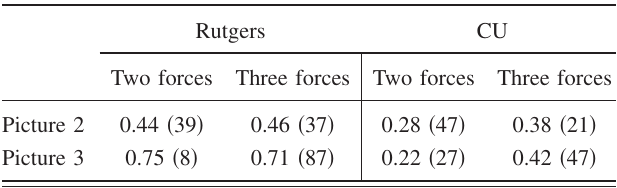
TABLE V. Fraction of students answering the challenge prob- lem correctly, broken down by whether they drew picture type 2 or 3 and whether they identified two or three forces correctly.